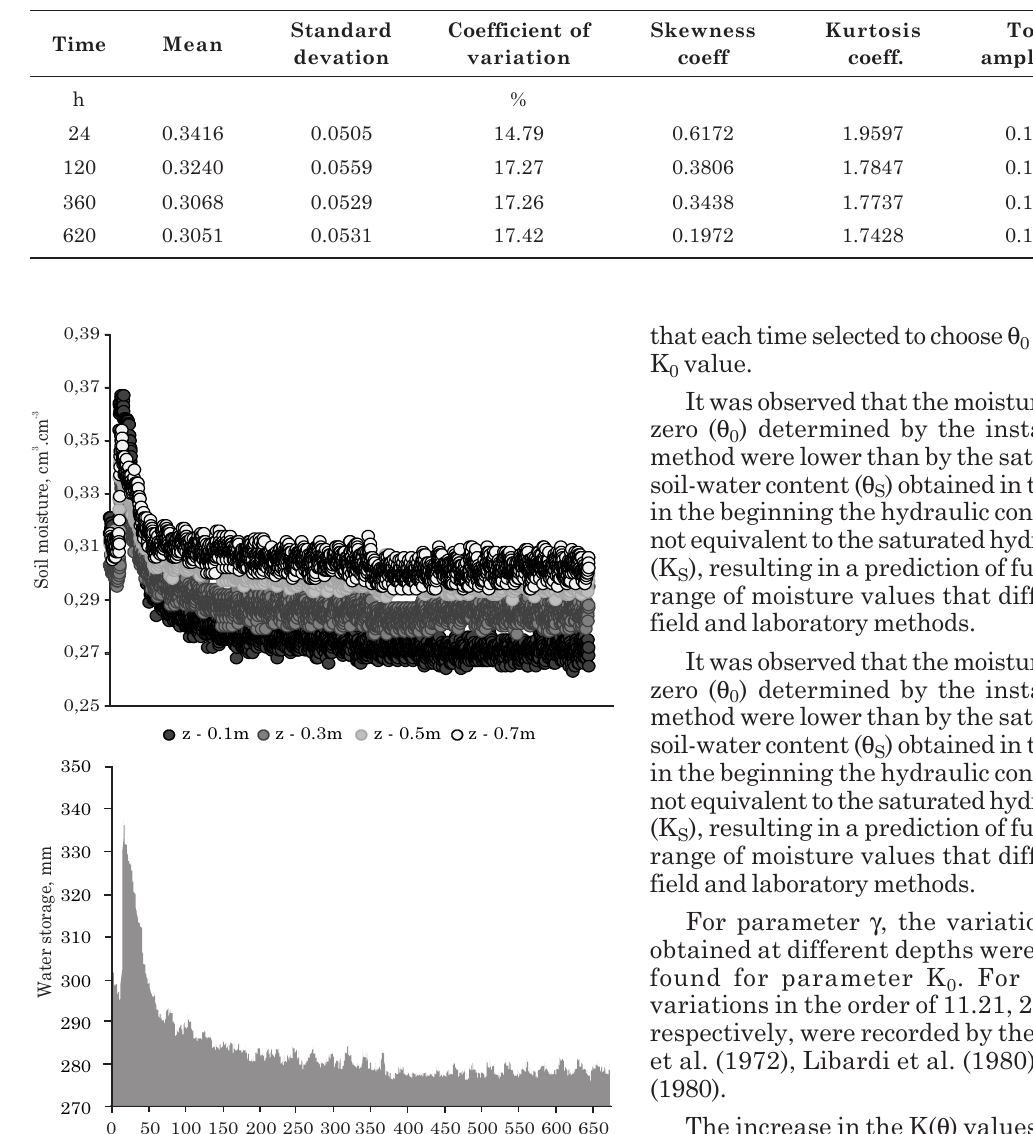
Table 2. Descriptive statistics for soil moisture (cm 3 cm -3 ) measured at 16 monitoring points and four times during soil water redistribution